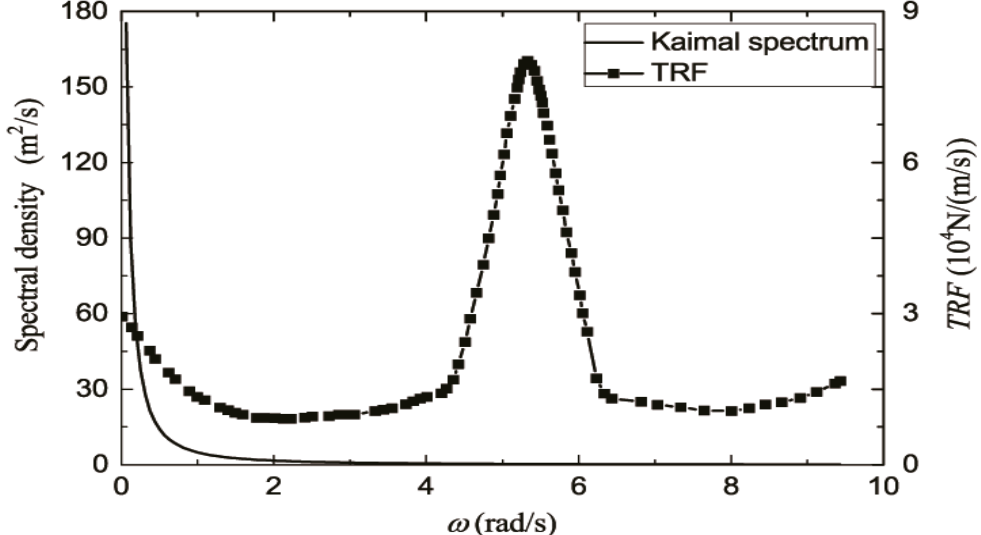
Figure 7. Wind excitation spectrum for the wind condition of Case 3 and transfer function (TRF) for the NREL 3 MW wind turbine. Energies 2019 , 11 , x FOR PEER REVIEW 13 of 19